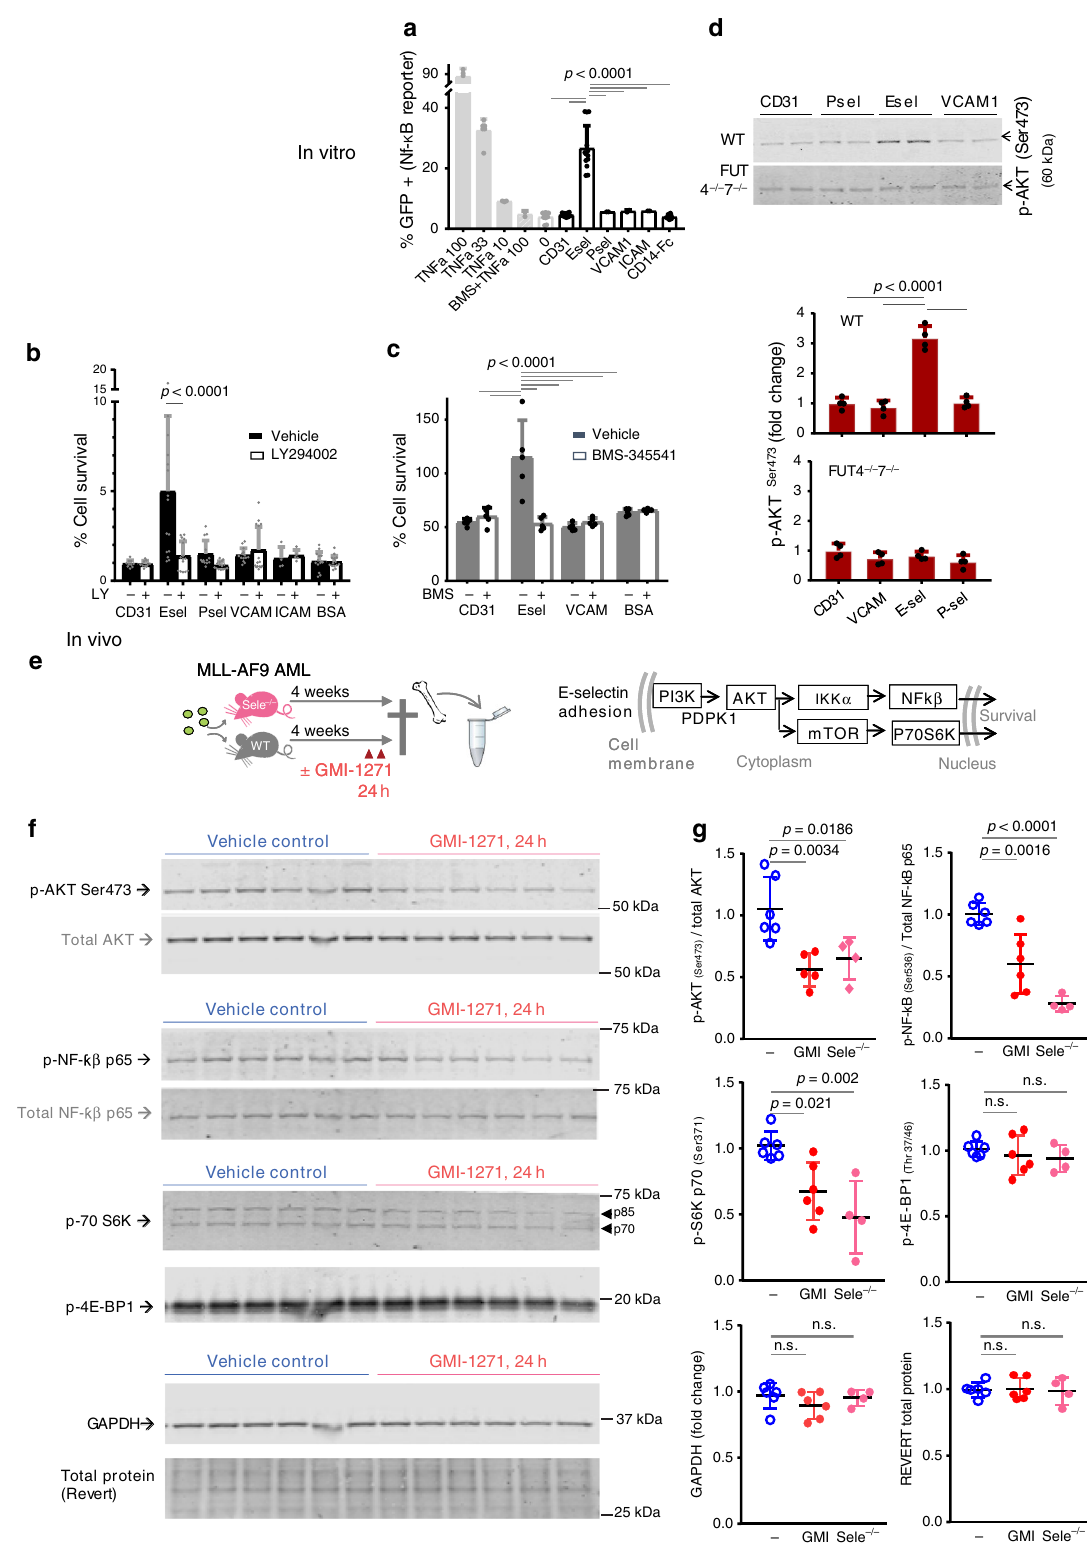
fl ow cytometry for GFP fl uorescence indicative of NF- κ B mediated transcription in the viable 7AAD − fraction. In vivo leukemia stem cell survival assay . Mice with advancing AML (5 – 20% GFP + KIT + AML blasts in blood, typically ~3.5 – 4 weeks post-transplant)